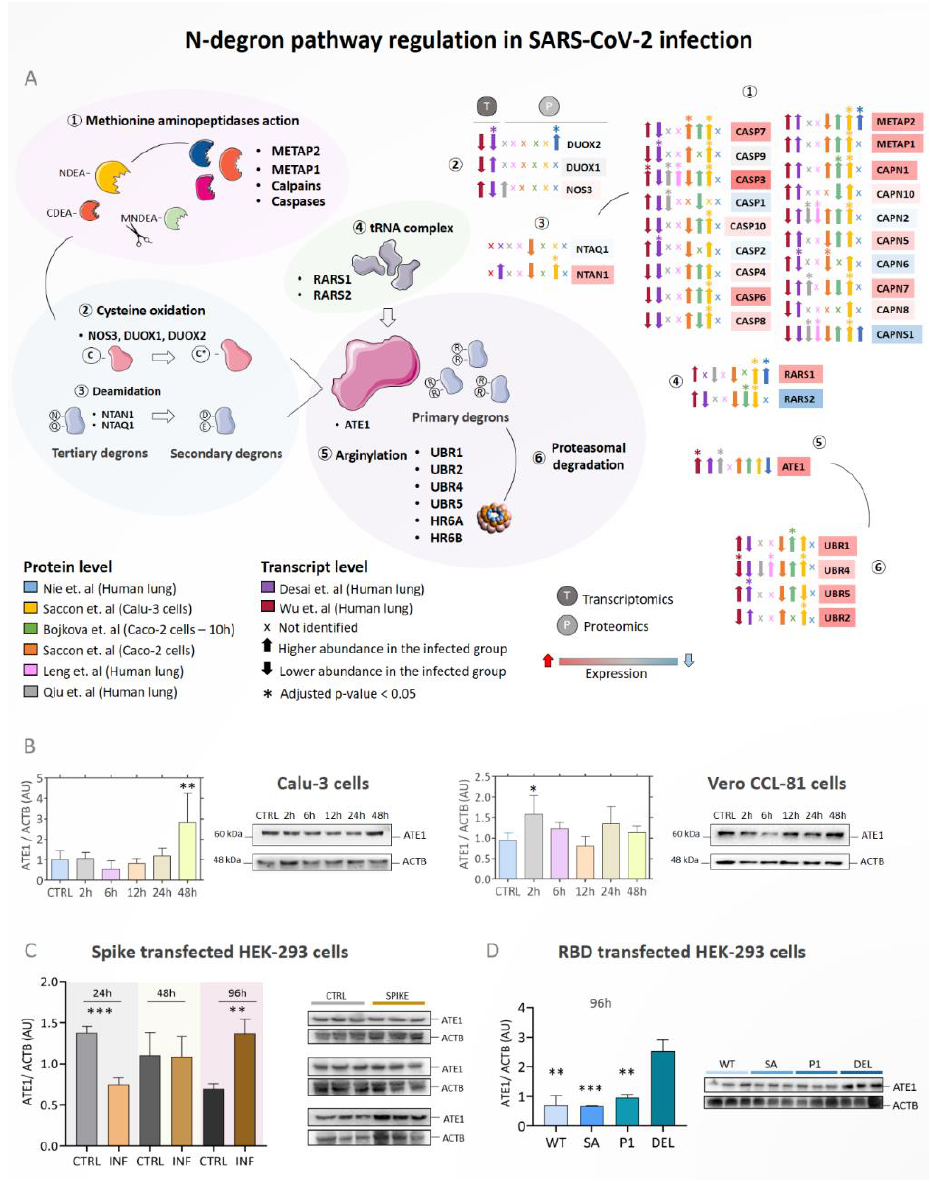
Figure 2. N-degron pathway modulation in infected in vitro and in vivo models. ( A ) Regulation of proteins involved in the N-degron pathway during SARS-Cov-2 infection. Proteins/genes were considered differentially regulated if they had a q -value < 0.05 (Benjamini–Hochberg) and were indicated by the symbol (*). The up arrows indicate proteins/genes with a higher abundance in the infected group (INF), and the down arrows indicate a lower abundance in the infected group. The color of the boxes of proteins/genes indicates the fold change (INF/CTRL) considering all the studies evaluated; the red color indicates higher abundance in the infected group and the blue color lower abundance in the INF group. The symbol (x) indicates that a protein/gene was not identified in the dataset; ( B ) Western blotting analysis of ATE1 protein in Calu-3 and Vero CCL-81 cells (n = 3) infected with SARS-CoV-2 (Wuhan strain) after 2 h, 6 h, 12 h, 24 h, and 48 h; ( C ) HEK 293T cells transfected with the SARS-CoV-2 (classical variant) spike protein; ( D ) modulation of ATE1 resulting from transfection in HEK 293T cells with the receptor-binding domains (RBD) of the WT (Wuhan), BETA (South Africa), P1 (Brazil), and DELTA (India) variants. Each point represents an independent experiment ( n = 3). The level of significance indicates *** p < 0.001; ** p < 0.005 in relation to the control group